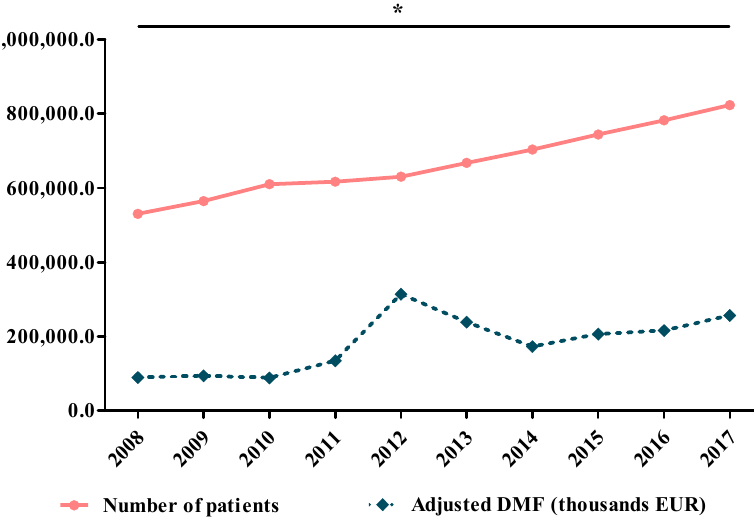
Figure 4. Evolution of the number of patients compared to the adjusted value of DMF (thousand EUR) (r = 0.73, * p = 0.016).